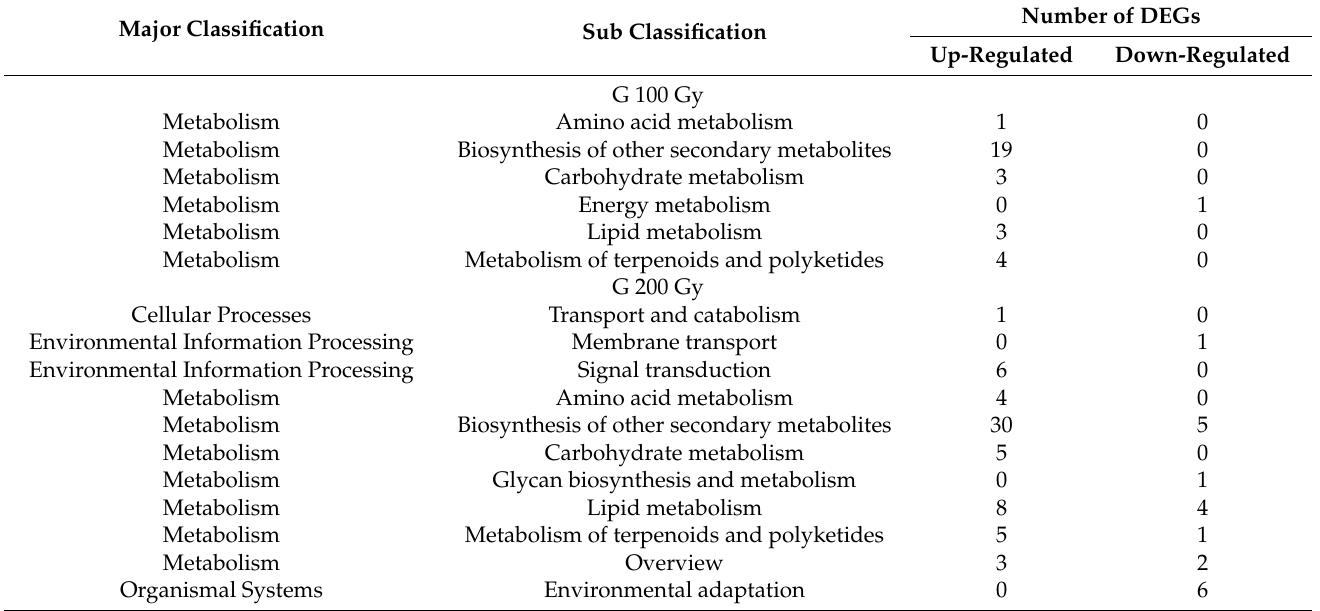
Figure 4. Gene Ontology (GO) term enrichment analysis of the up ( a ) down ( b ) regulated genes of cowpeas exposed to different dose rates of proton-beams. (Blue bar: Biological Process, Red bar: Cellular Component, Grey bar: Molecular Function). Table 1. Kyoto Encyclopedia of Genes and Genomes (KEGG) enrichment analysis of the up- and down-regulated genes of cowpeas exposed to different dose rates of